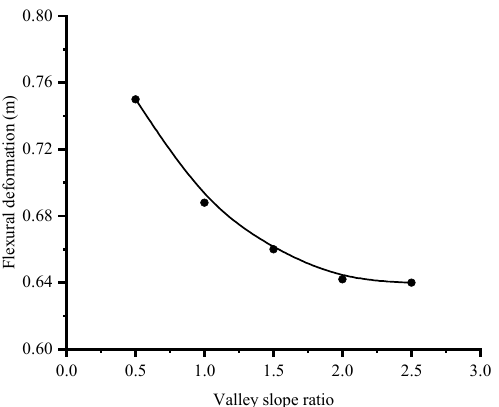
Figure 23. Relationship between flexural deformation maximum of SACC and valley slope ratio.